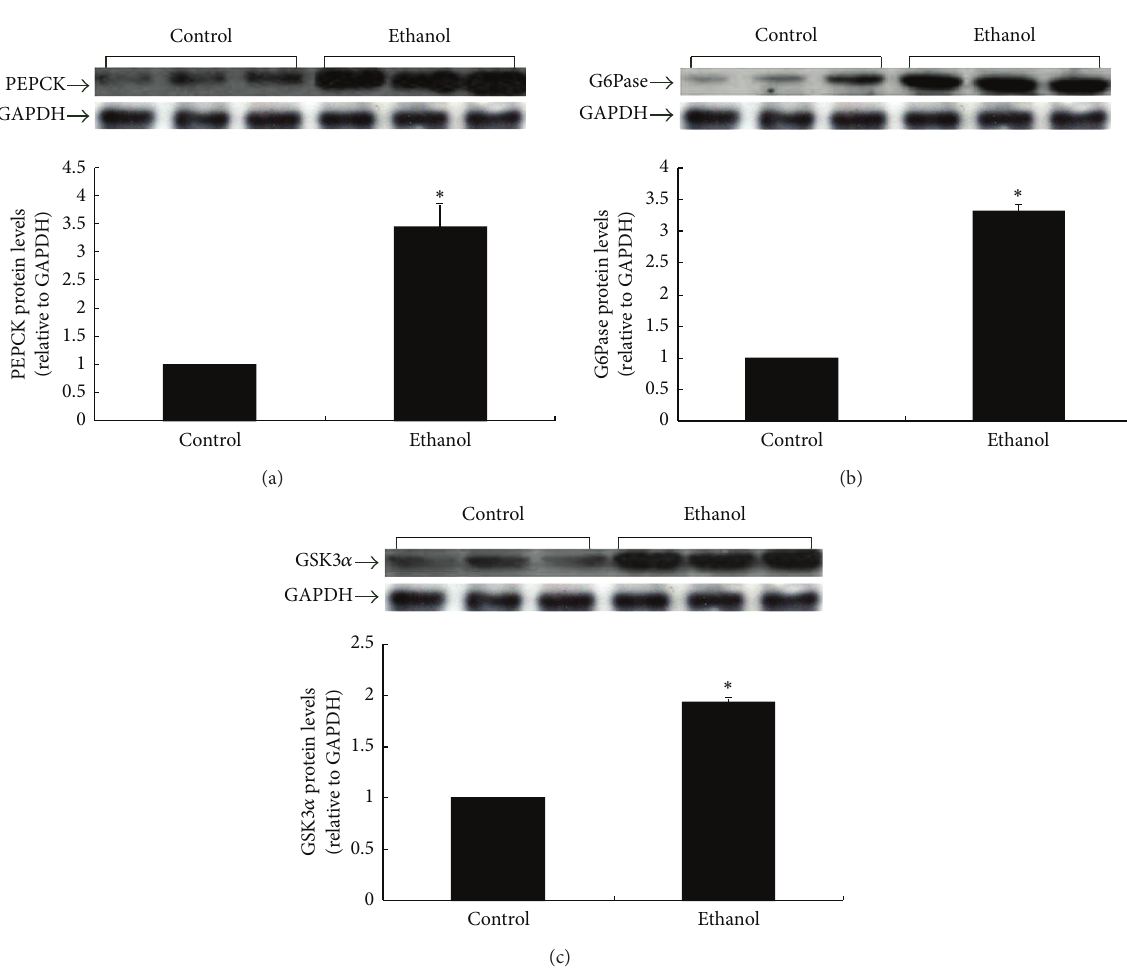
Figure 3: PEPCK, G6Pase, and GSK3 𝛼 proteins in the liver of control and ethanol rats after 3 months of ethanol intake (8g ⋅ kg −1 ⋅ d −1 ). Protein levels are expressed relative to the control and shown as the mean ± SEM ( 𝑛 = 6 ). ∗ 𝑃 < 0.05 ethanol versus